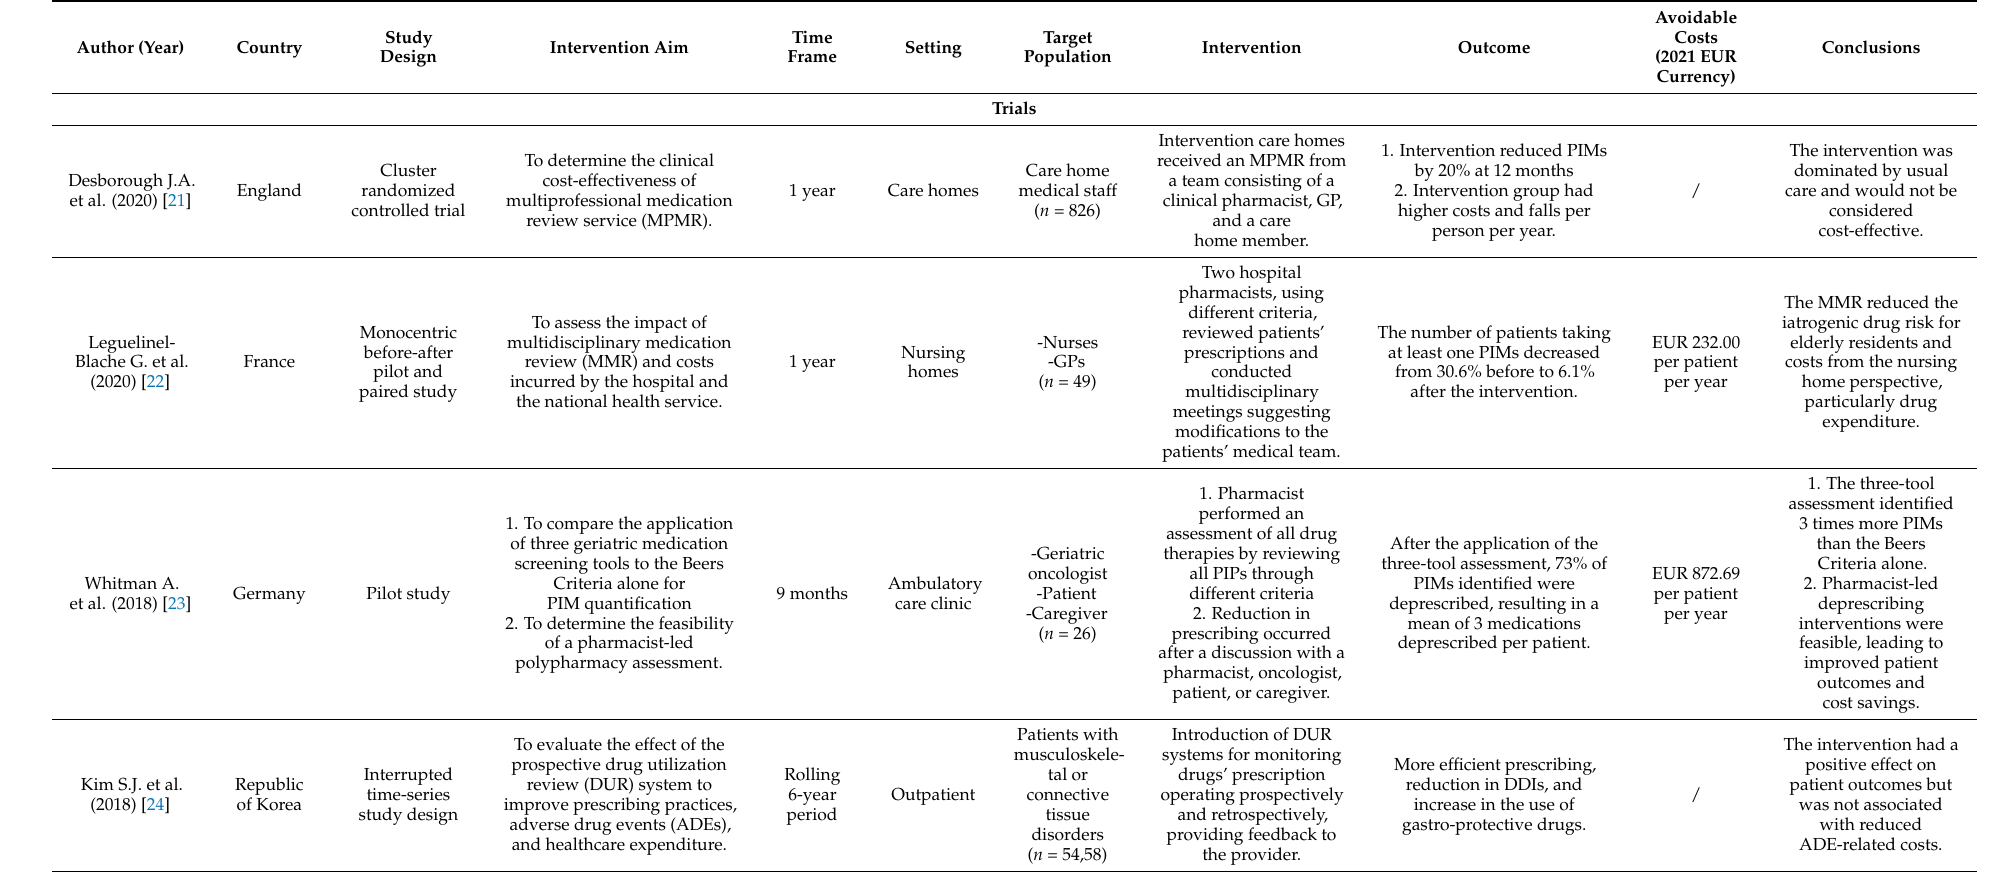
Table 4. Characteristics of included studies with